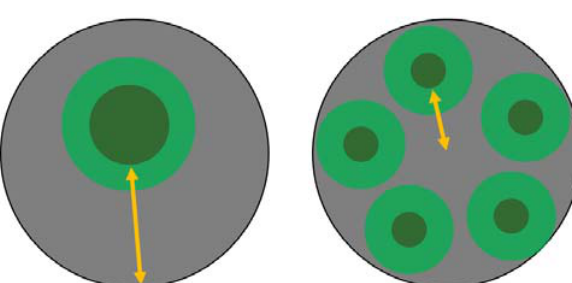
Figure 2. Illustration for the importance of accessibility and proximity beyond the amount of UGS (dark green – UGS, light green – ideal walking distance, yellow arrow – maximum walking distance to the closest